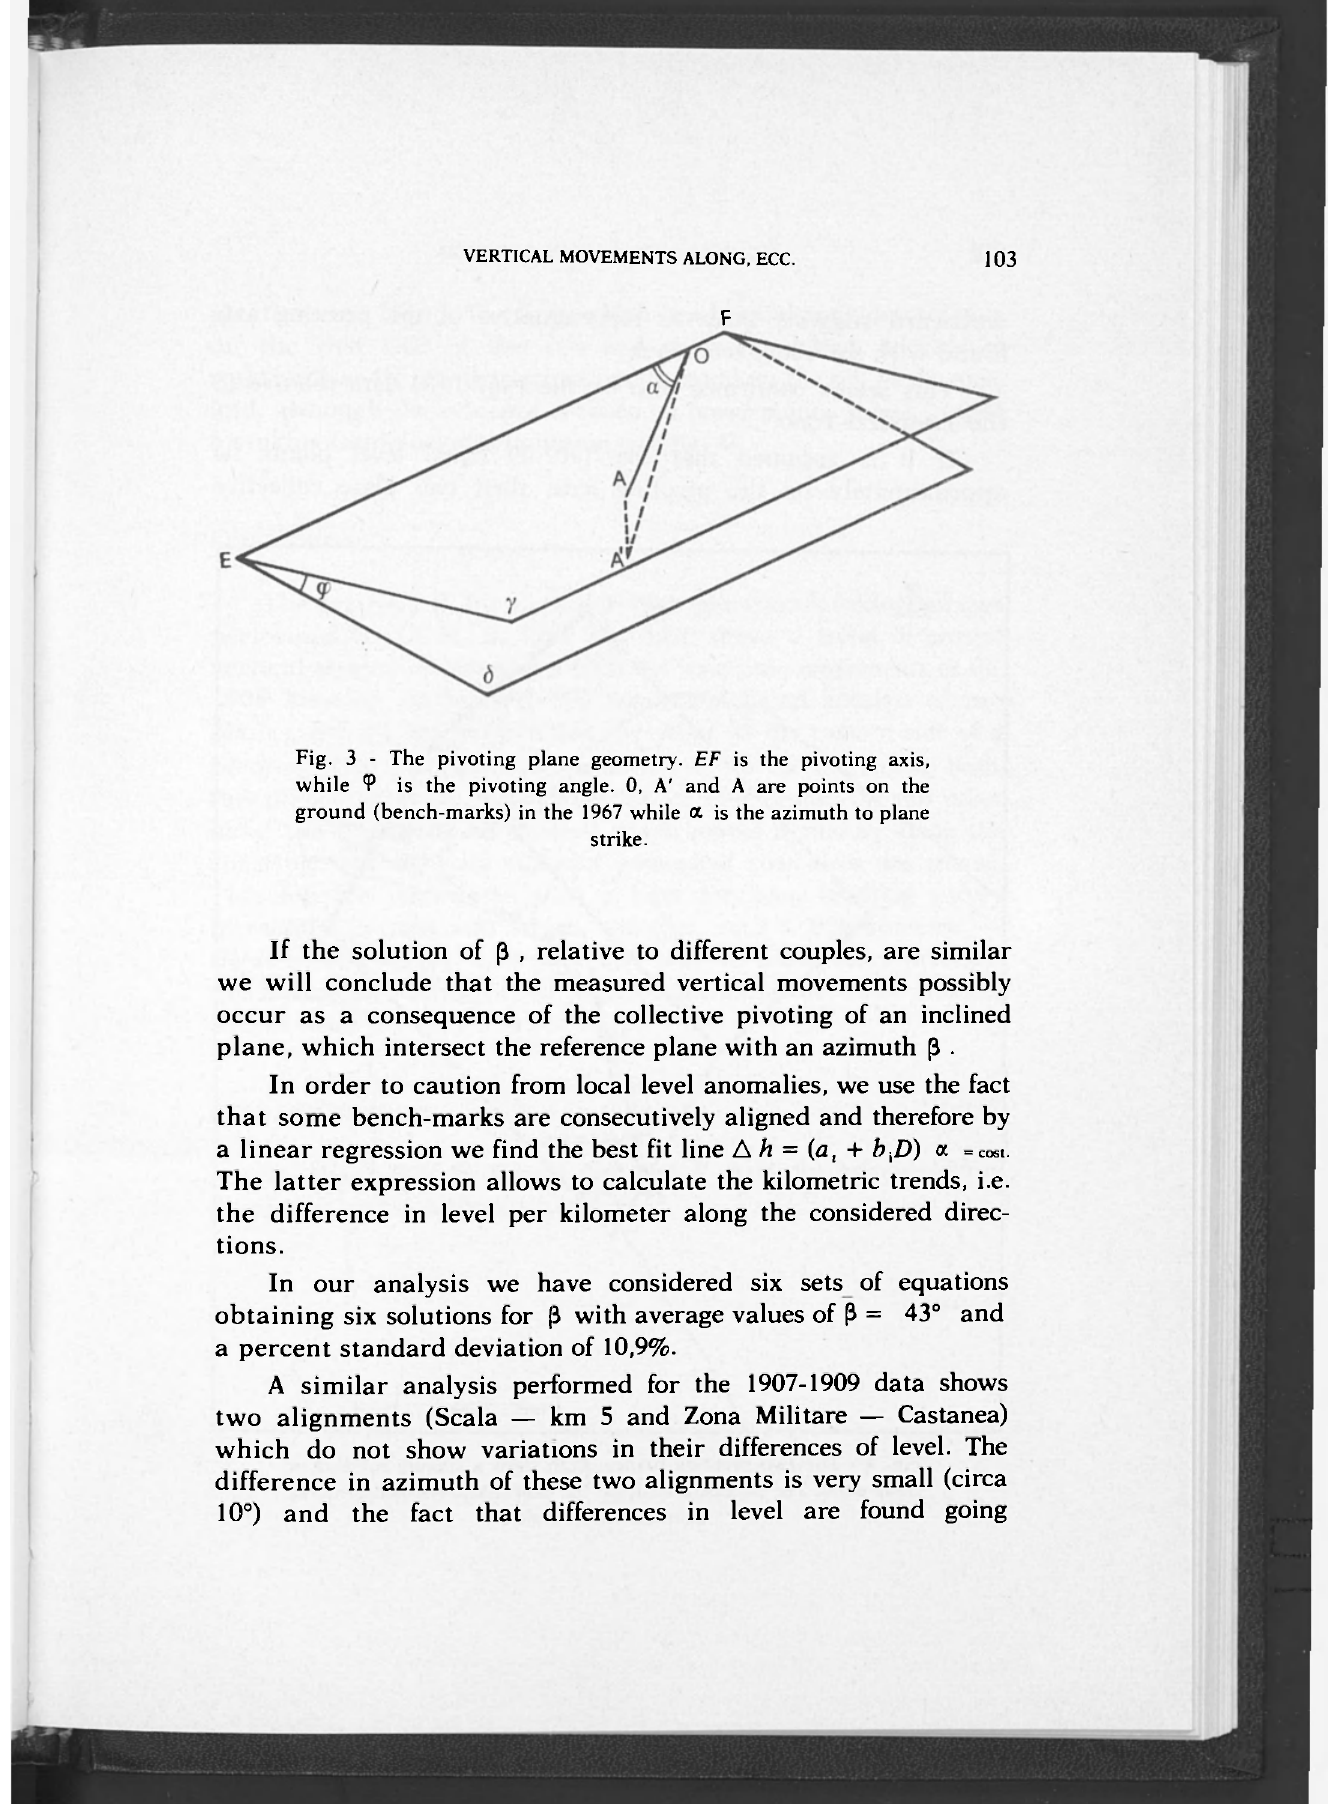
Fig. 3 - The pivoting plane geometry. EF is the pivoting axis, while 9 is the pivoting angle. 0, A' and A are points on the ground (bench-marks) in the 1967 while a. is the azimuth to plane